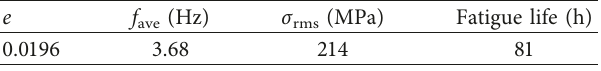
Table 4: Computational parameters of random vibration fatigue.